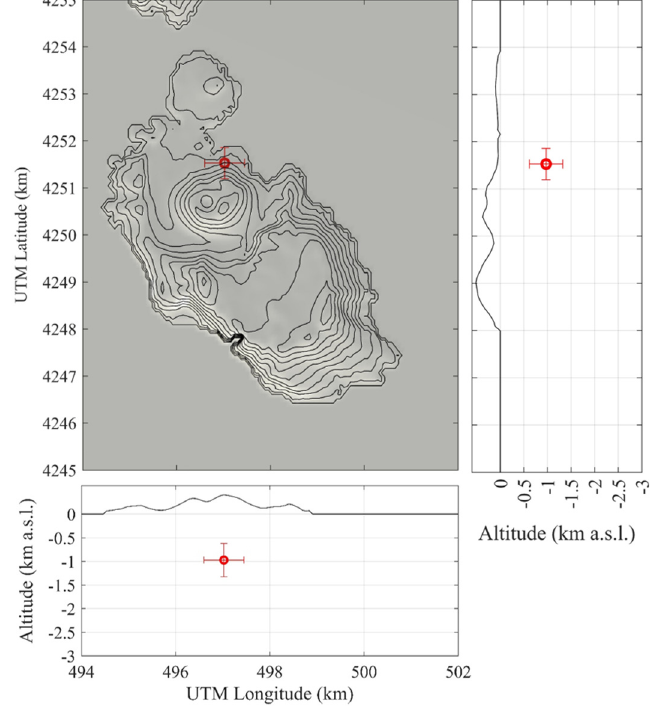
Figure 14. The average value of all VLP seismicity locations in the map and sections with error bar (standard deviation). Only the location with a minimum station number = 5, minimum amplitude value = 0.006 (mm s − 1 ), and minimum radial semblance= 0.6 is considered. [83] © DLR2018.